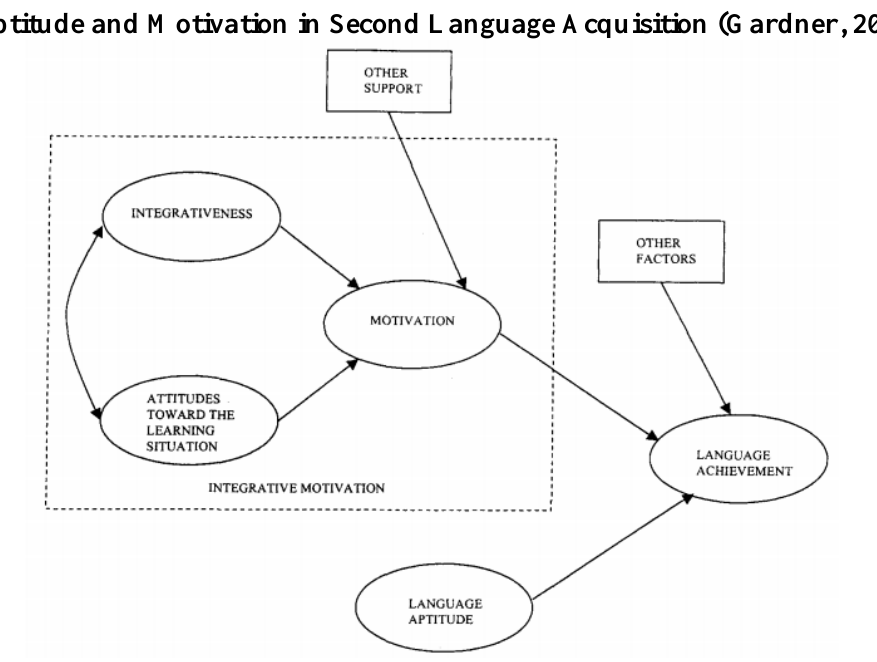
Role of Aptitude and Motivation in Second Language Acquisition (Gardner, 2000, p.17